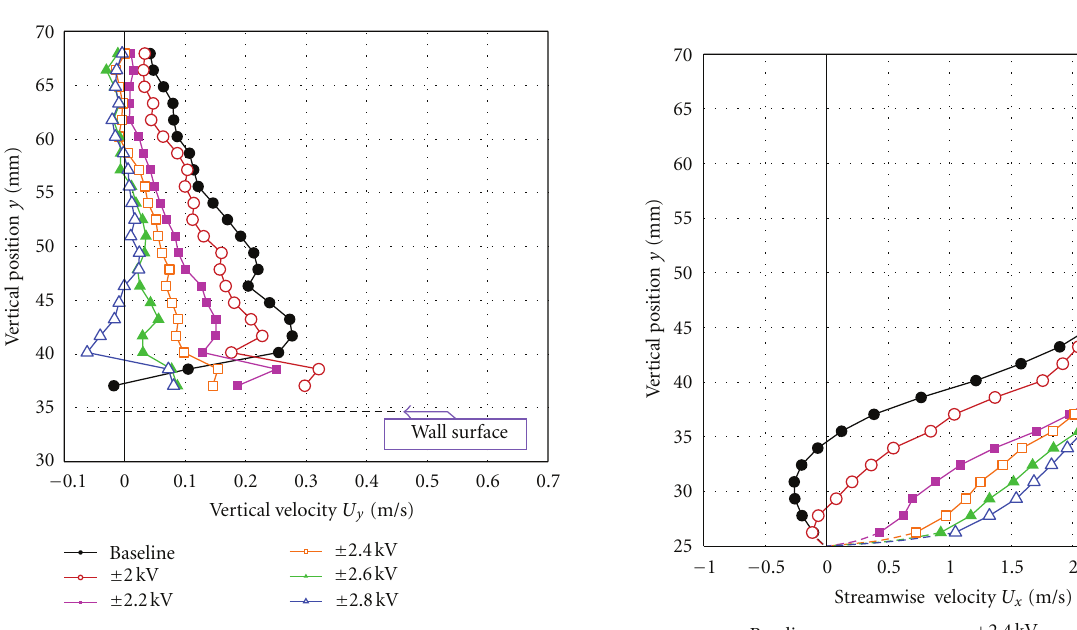
Figure 11: Flow angle distributions near plasma actuator ( x = 29.7 mm).